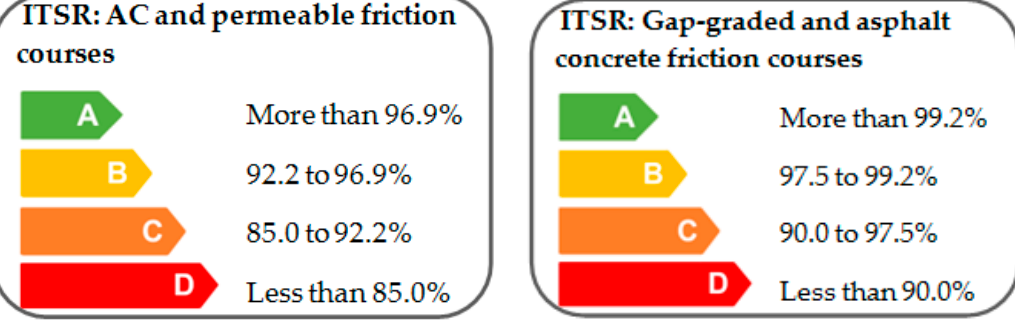
Figure 16. ITSR labels based on the type of mixture.